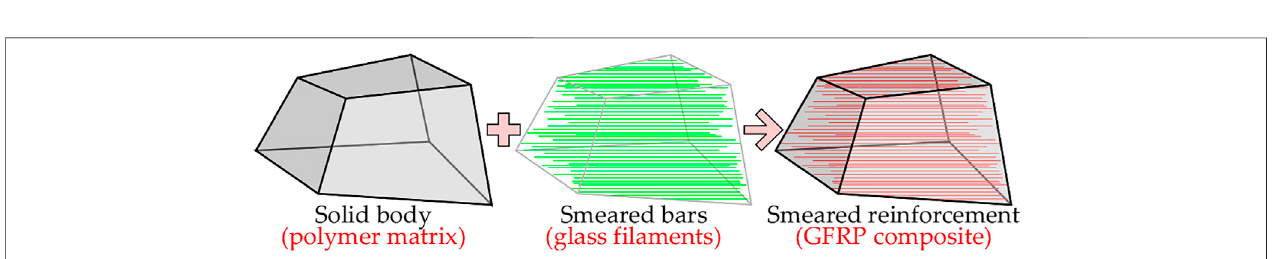
FIGURE 9 | Failure mechanisms: (A) F IBERLINE pro fi les; (B) U GIRA samples.